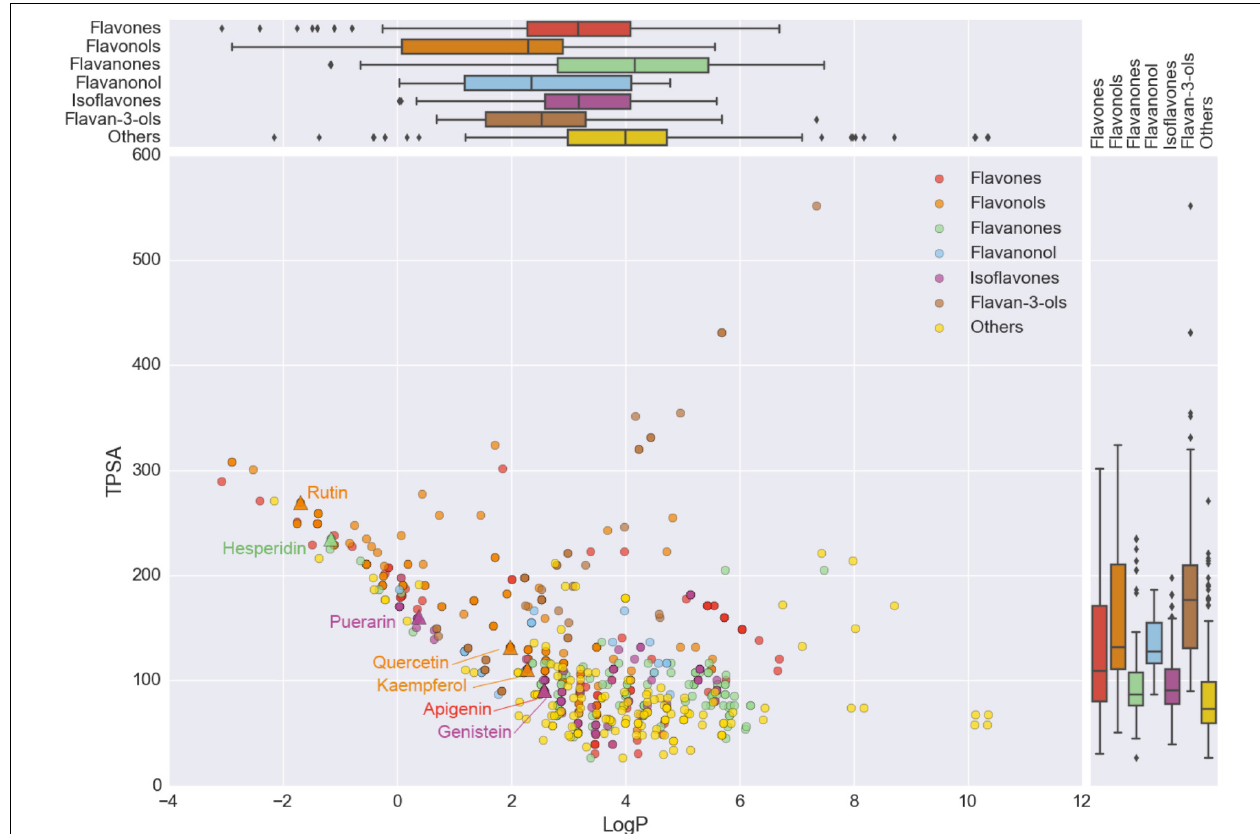
FIGURE 5 | Distribution of LogP and TPSA in different flavonoids. Different color represents different flavonoid subclasses. X -axis represents the value of LogP, while Y -axis represents the value of